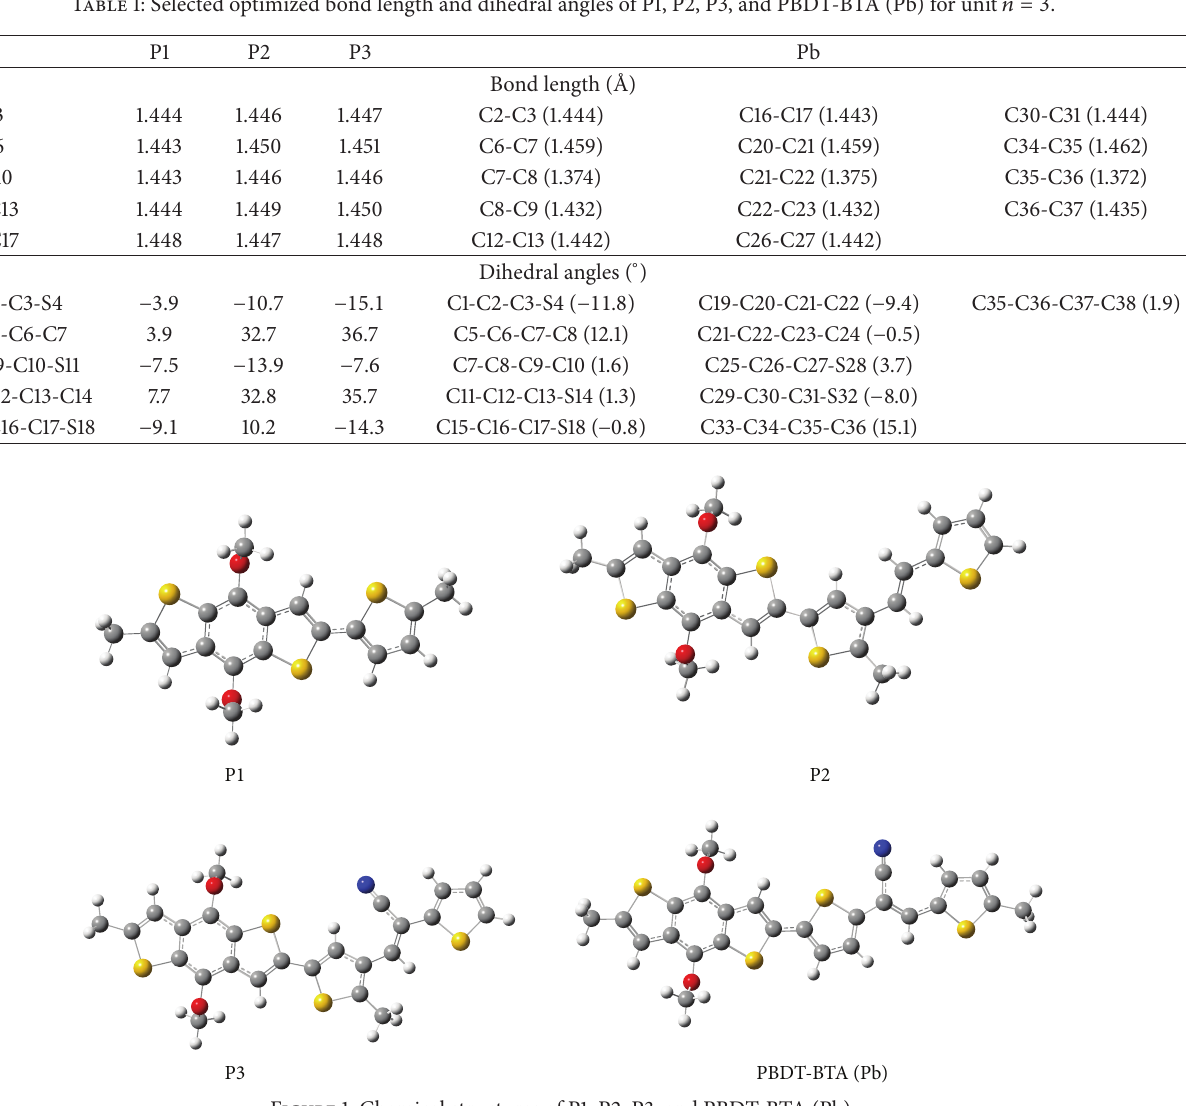
Figure 1: Chemical structures of P1, P2, P3, and PBDT-BTA